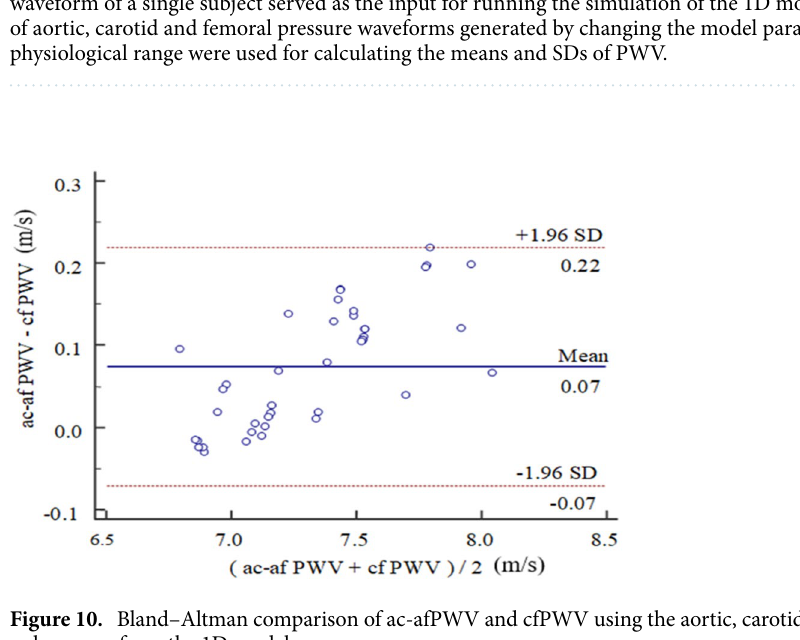
Figure 10. Bland–Altman comparison of ac-afPWV and cfPWV using the aortic, carotid and femoral pressure pulse waves from the 1D